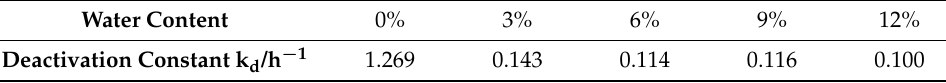
Figure 2. Cracking of 4-propylphenol over ZSM-5 in the presence of different amounts of water. Reaction conditions: 2% propylphenol in N 2 ; 0.2 g of calcined ZSM-5; 350 °C; WHSV = 31.1 h −1 . Table 1. Deactivation rate constants for the conversion of 4-propylphenol in the presence of different amounts of water.